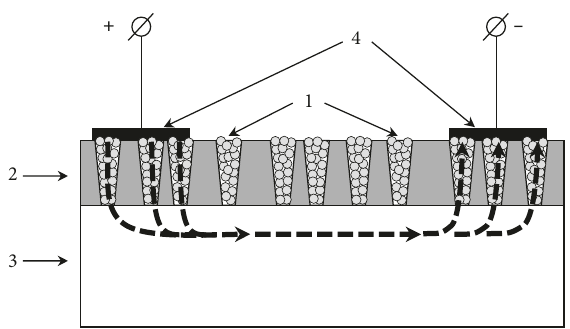
Figure 2: Schematic representation of SiO 2 (Ni)/Si nanosystems. (1) Metal in the pores, (2) silicon oxide layer, (3) silicon substrate, and (4)